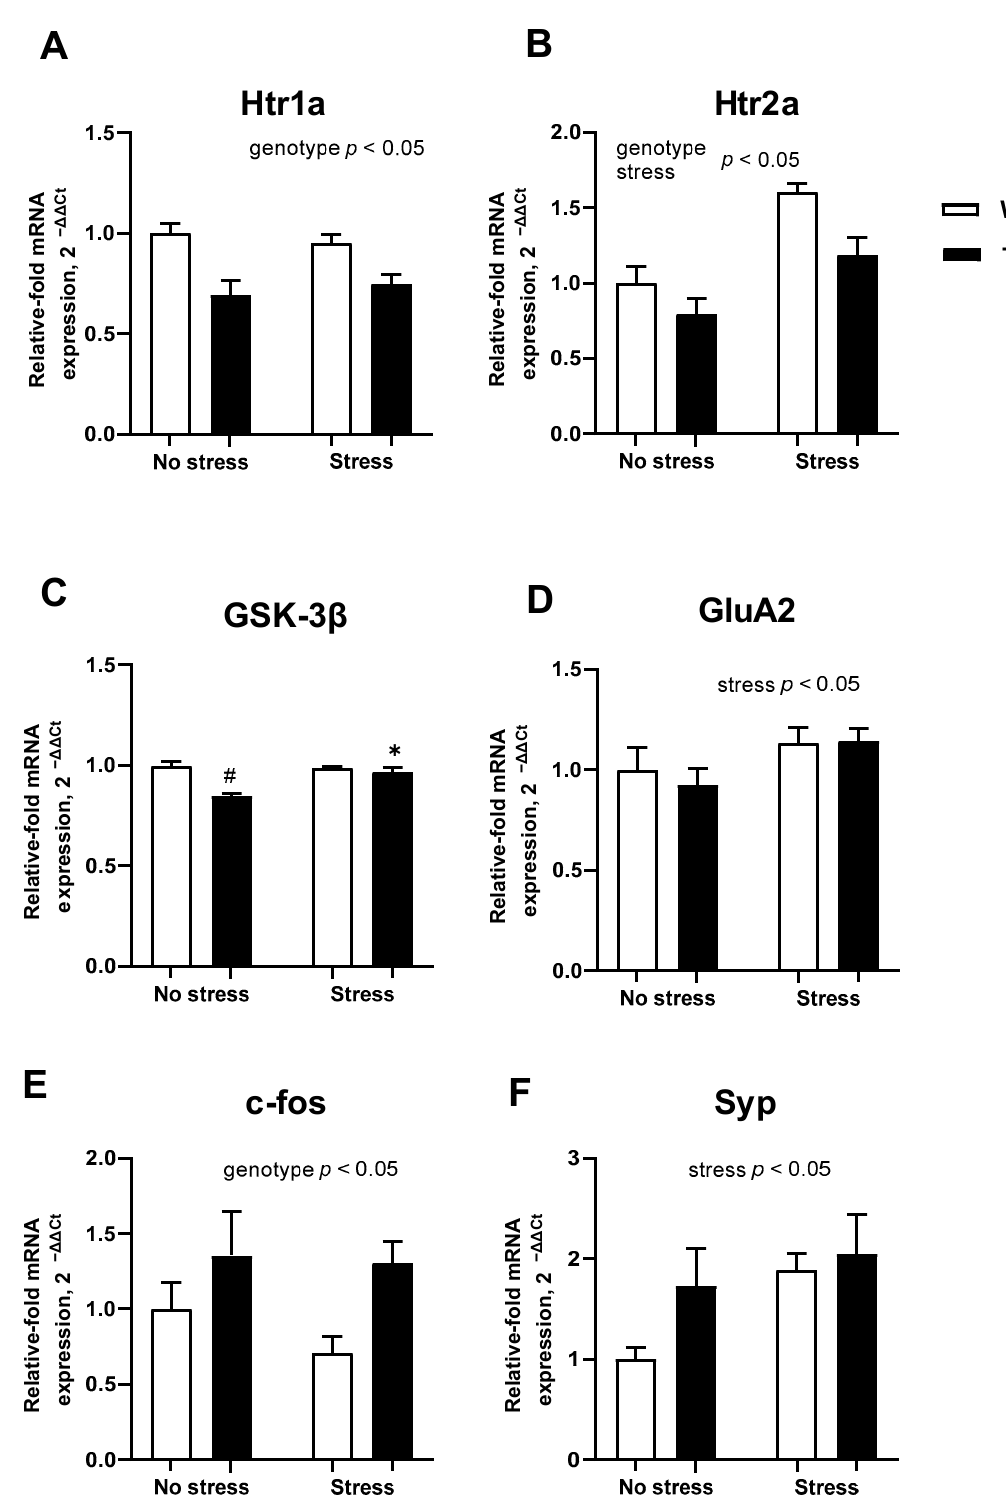
Figure 3. Expression of 5-HT receptors, GSK-3 β , GluA2 , c-fos and Syp in the brain of stressed Tph2 +/ − mice. ( A ) Compared to control groups, Htr1a expression was significantly lowered in Tph2 +/ − animals. WT no stress (NS) n = 4, WT stress (S) n = 9, Tph2 +/ − NS n = 6, Tph2 +/ − S n = 6. ( B ) In comparison to non-stressed animals, in stressed groups, Htr2a expression was significantly higher. Irrespectively of stress, Htr2a expression was higher in wild type groups. WT NS n = 4, WT S n = 8, Tph2 +/ − NS n = 6, Tph2 +/ − S n = 6. ( C ) Significantly higher GSK-3 β expression in both the stressed Tph2 +/ − group